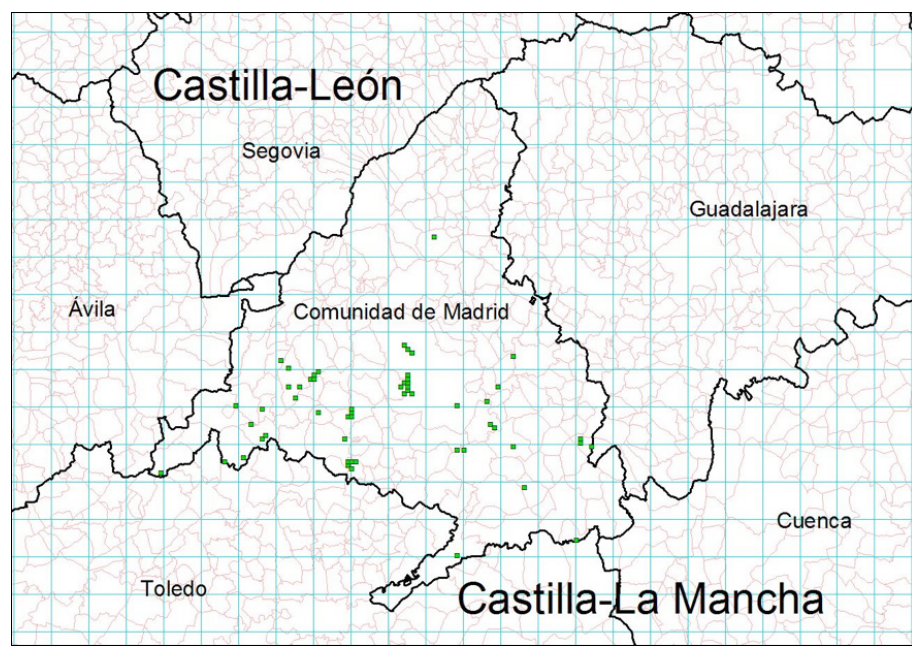
Figure 1. Distribution range of Himantoglossum robertianum in Madrid. Every green square represents a UTM cell of 1 km side (datum